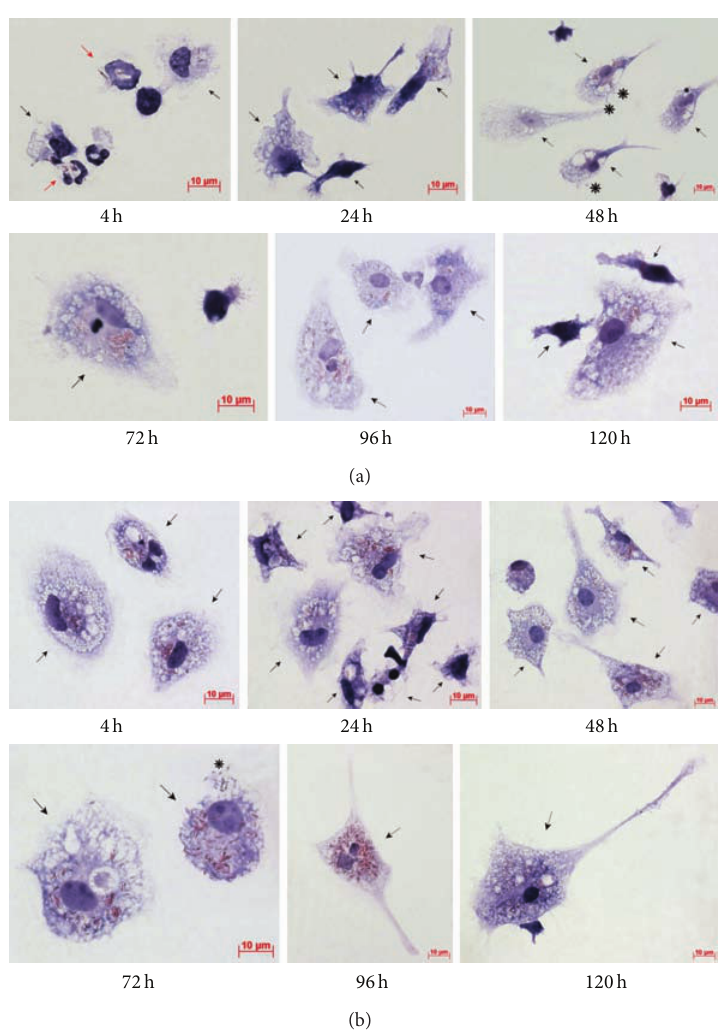
Figure 2: Cells with BCG-mycobacteria in the cultures of (a) bone marrow macrophages and (b) peritoneal macrophages following infection with the BCG vaccine in vitro and after culture for several hours. Acid-fast BCG-mycobacteria stained by the ZN method. The scale bars are 10 𝜇 m each. Infected macrophages and neutrophils are indicated by the black and red arrows, respectively. Nonacid-fast BCG-mycobacteria (blue color) eliminated by macrophages are indicated by the black snowflakes. Abbreviations as in Figure